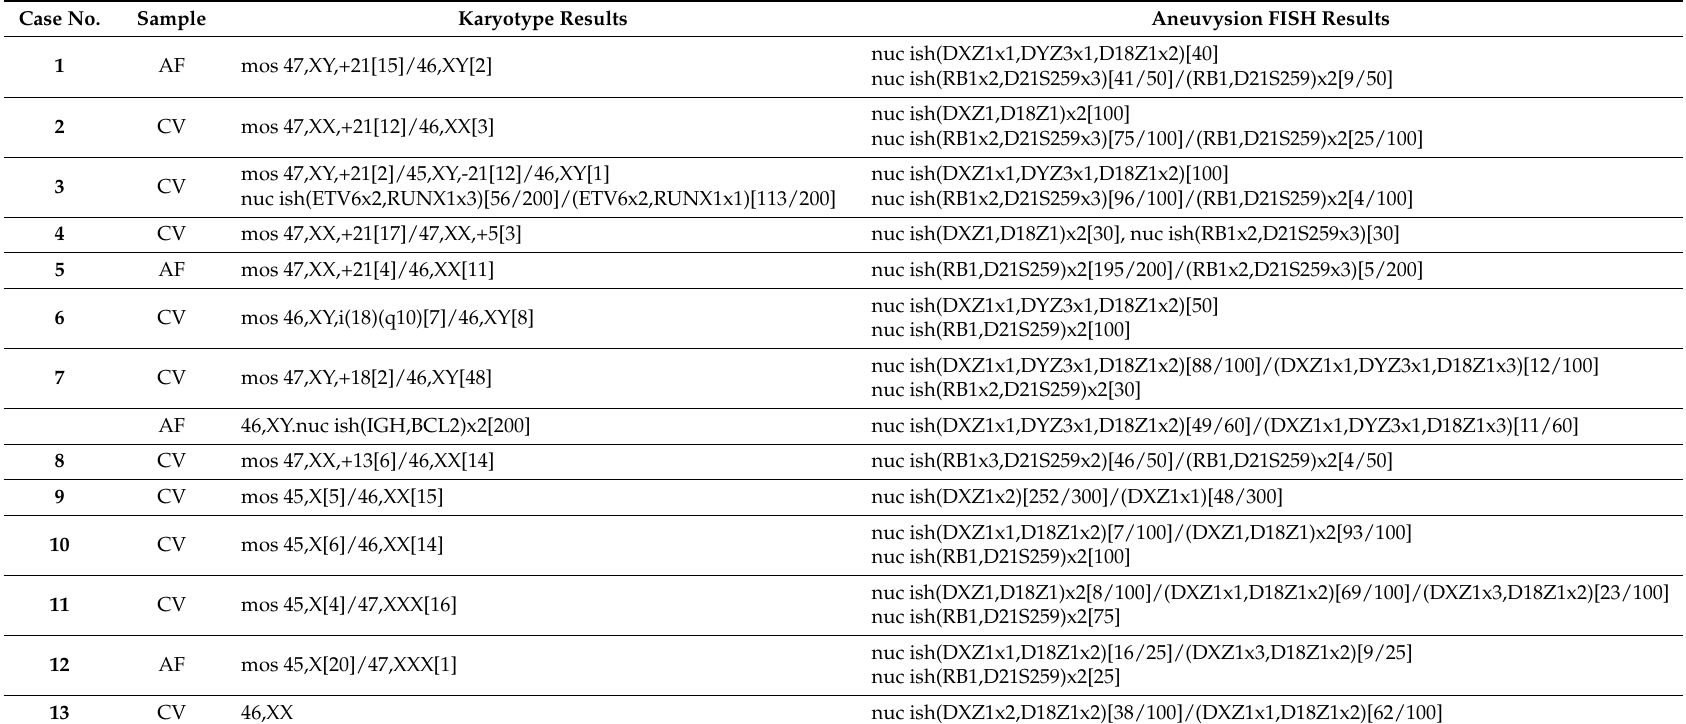
Table 2. Chromosome and FISH results on mosaic cases of common